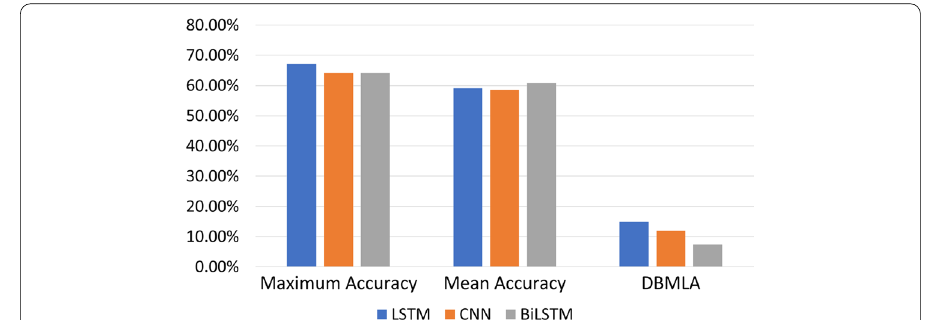
Fig. 12 Prediction accuracy: Comparison of LSTM, CNN and BiLSTM models